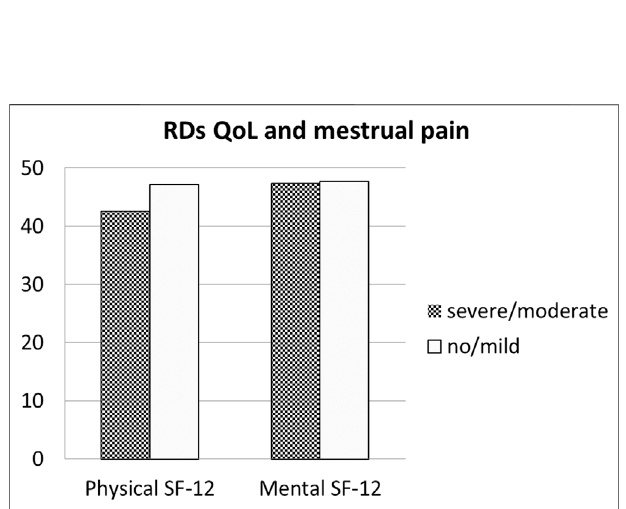
FIGURE 2 | Quality of Life in RDs patients: Comparison between patientswithdysmenorrheaandwithnormalormildpainduringmenstruation. Legend: RDs: Rheumatic diseses.